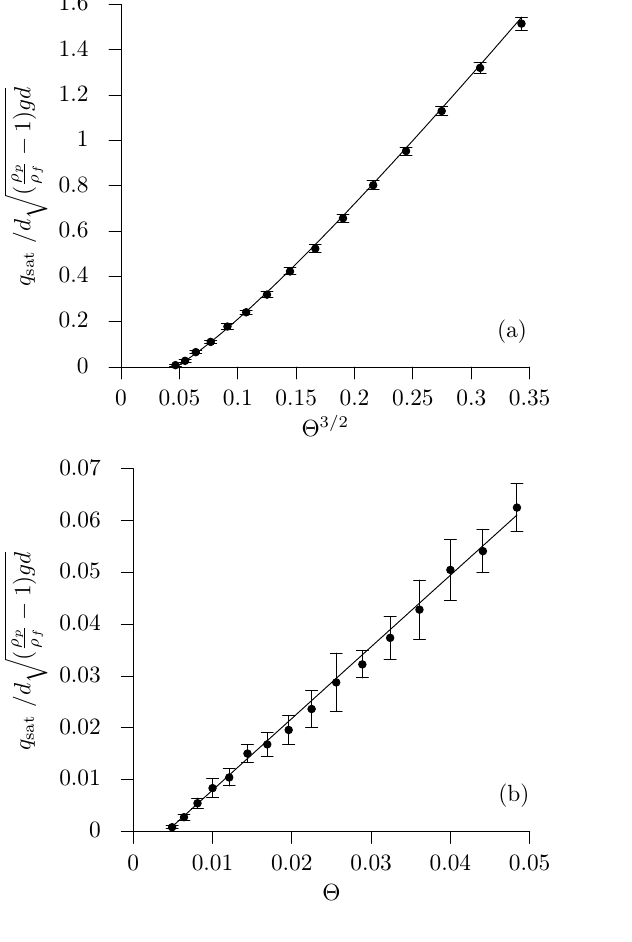
q (ρ p /ρ f − 1 )gd 3 versus 2 3 / 2